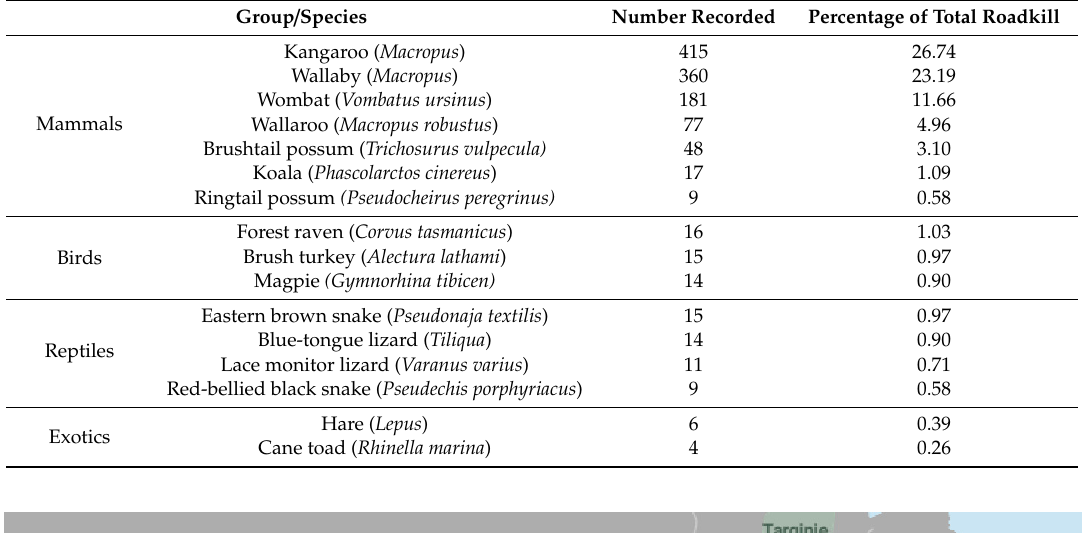
Table 4. Principal roadkill taxa between 28 September 2019 and 31 December 2019 by group, identified by experts using photographic RRApp data.